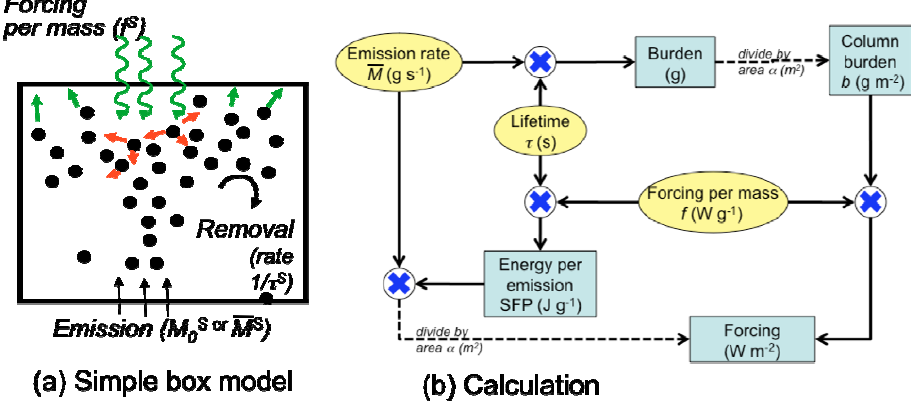
Figure A1. (a) Simple box model demonstrating factors that govern impacts on energy balance due to addition of a species S . Net energy addition per mass ( f S ) is shown by green arrows indicating incoming and reflected solar radiation, and red arrows indicating absorption and dissipation as heat. Other interactions with radiation (e.g. re-emission of infrared energy, absorption by the species on the Earth’s surface) can be framed in similar terms but are not presented here. First-order removal has rate constant 1/ τ S (inverse of lifetime). (b) Calculation flow for box in steady state, with blue “x” indicating multiplication (e.g., total burden = lifetime multiplied by emission rate). Energy added (specific forcing pulse) does not depend on emission rate.